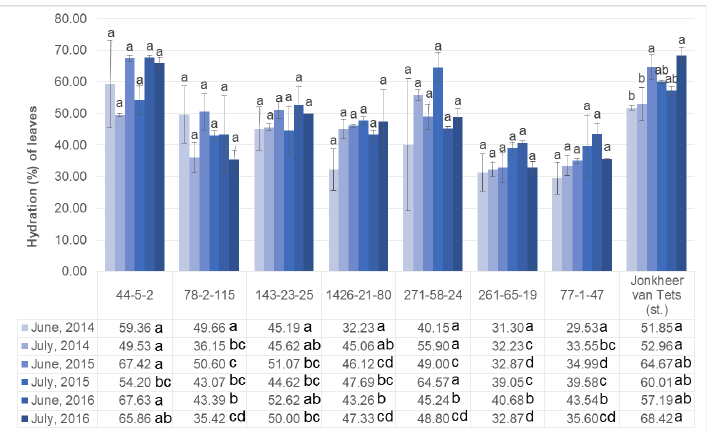
Figure 1. Hydration ability of leaves of selected red currant genotypes during growing period. (Letters above the columns are used to compare growing periods separately for each genotype; and letters next to the values in figure table are used to compare genotypes separately for each growing period. Different letters shown represent significant difference among the values according to Tukey’s HSD test).